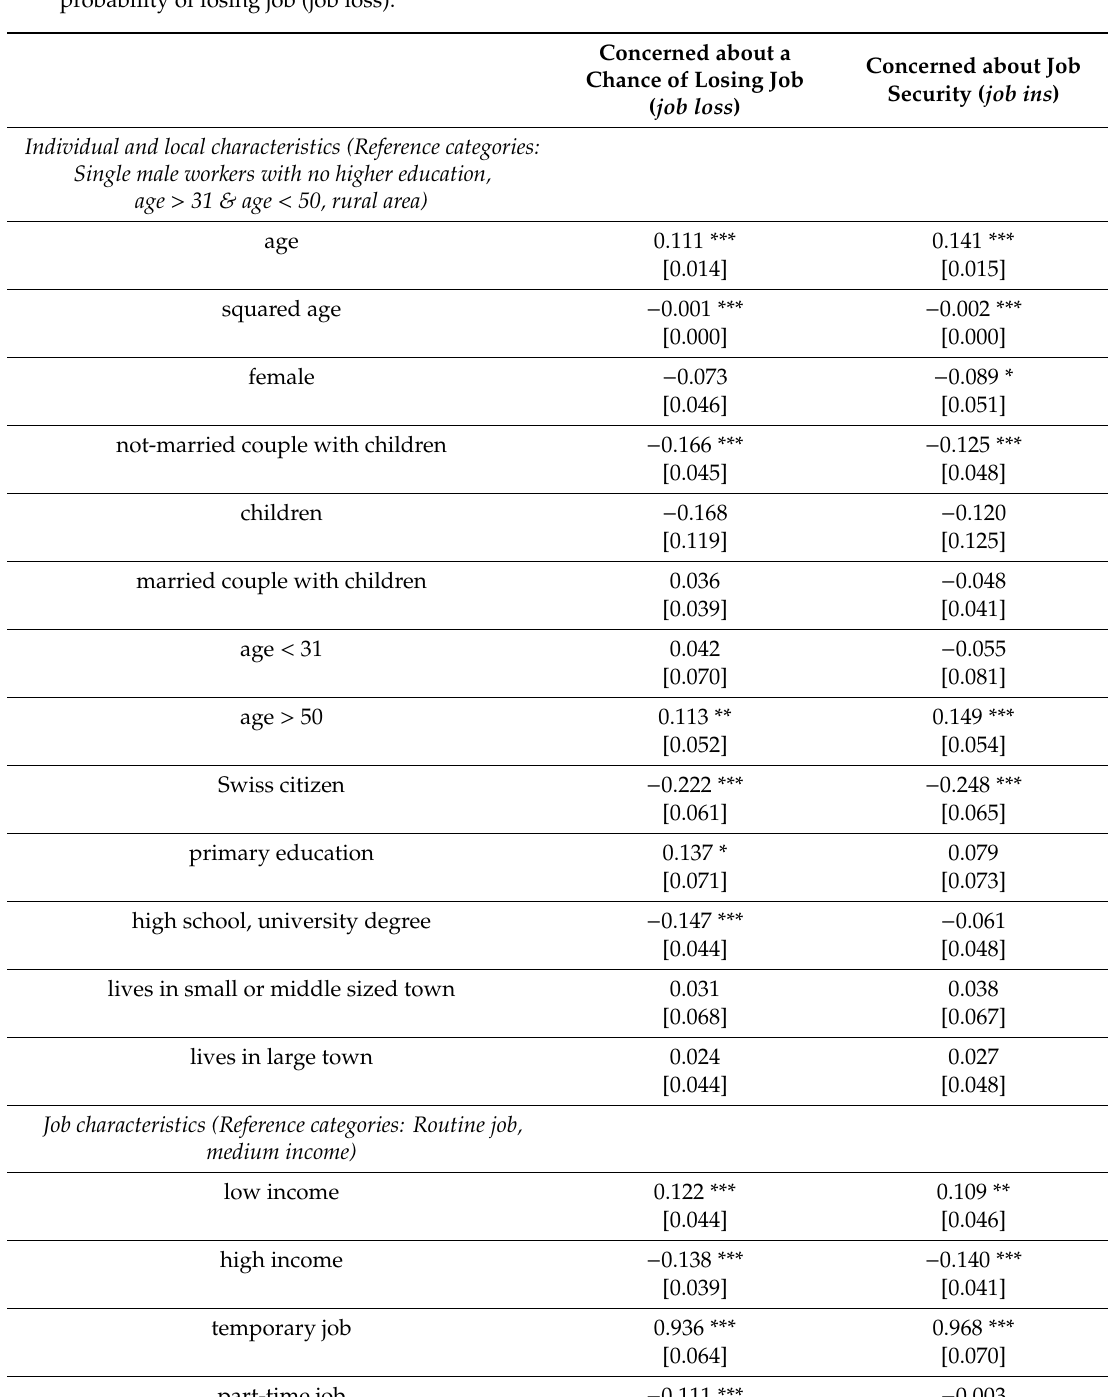
Table 3. Panel Ordered Probit estimates for degree of satisfaction with job security (job ins) and probability of losing job (job